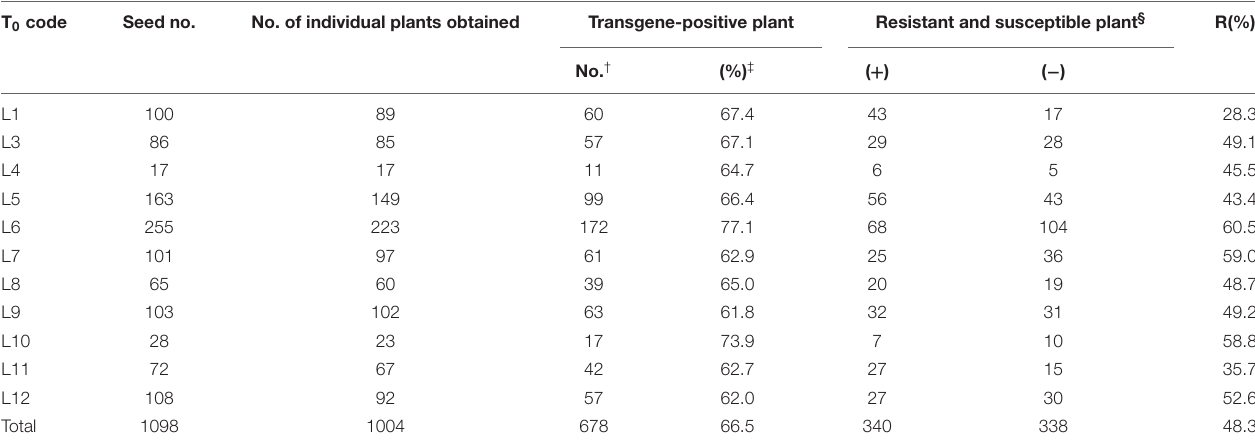
FIGURE 2 | Evaluation of SMV accumulation in detached-leaves of T 1 progeny of transformed soybean. (A) SMV inoculation and maintenance of the detached-leaf. (B) The genome PCR (upper side) and ELISA (down side) assay of the un-inoculated half of the unifoliate leaf at 7 dpi. The band size of S1 fragment and Tubulin gene are 492 and 557 bp, respectively. NT: non-transgenic soybean; 1 to 24 are the individual transgenic T 1 -plants. TABLE 4 | Transgene-positive and resistant ratios in T 1 generation from in vitro leaf-assay. T 0